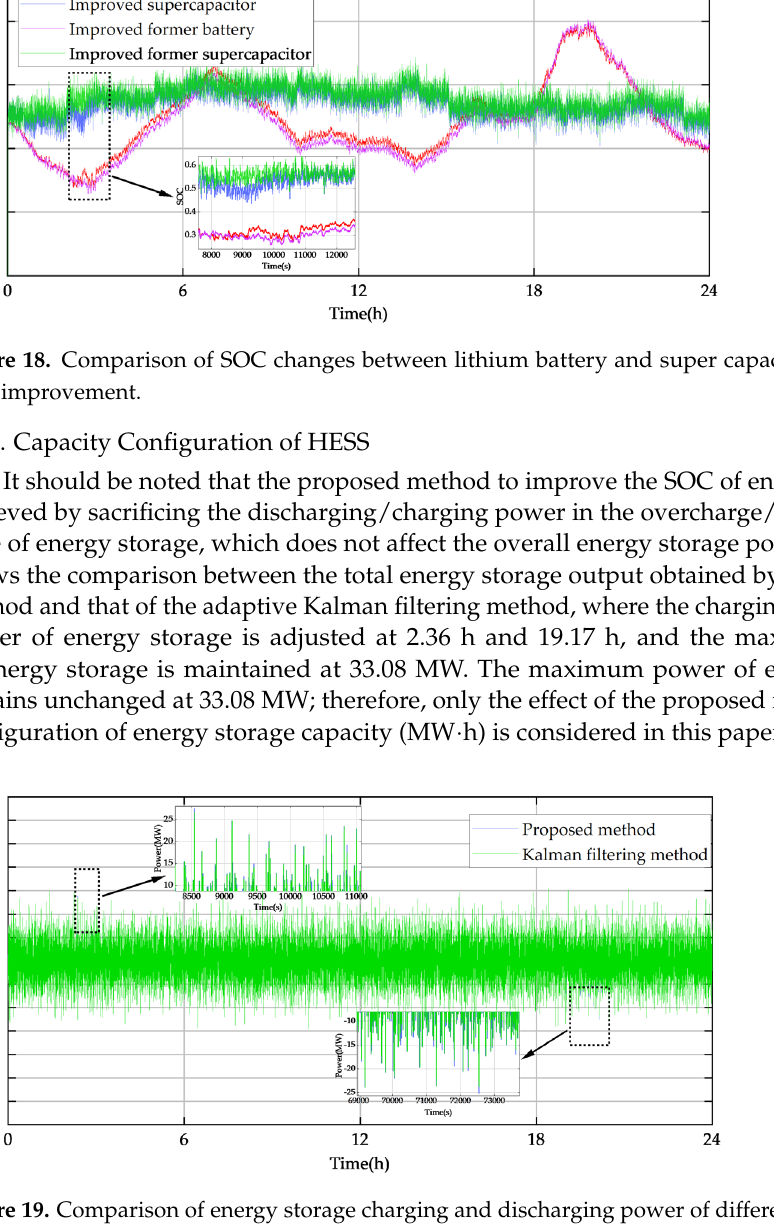
Figure 19. Comparison of energy storage charging and discharging power of different methods.